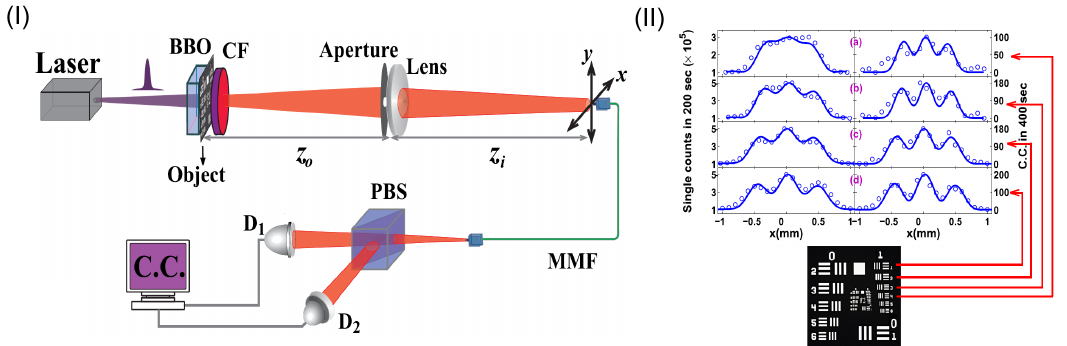
Figure 7. ( I ): Schematic of experimental setup for realizing super-resolution imaging with entangled two-photon source illumination. The entangled two-photon source is generated by optical parametric down conversion with the betabarium-borate (BBO) crystal. ( II ): Super-resolution images ( right column ) in comparison with the conventional intensity images ( left column ). The object to be imaged is marked by the red lines in the figure. The figure is reproduced with permissions from Ref. [39] of